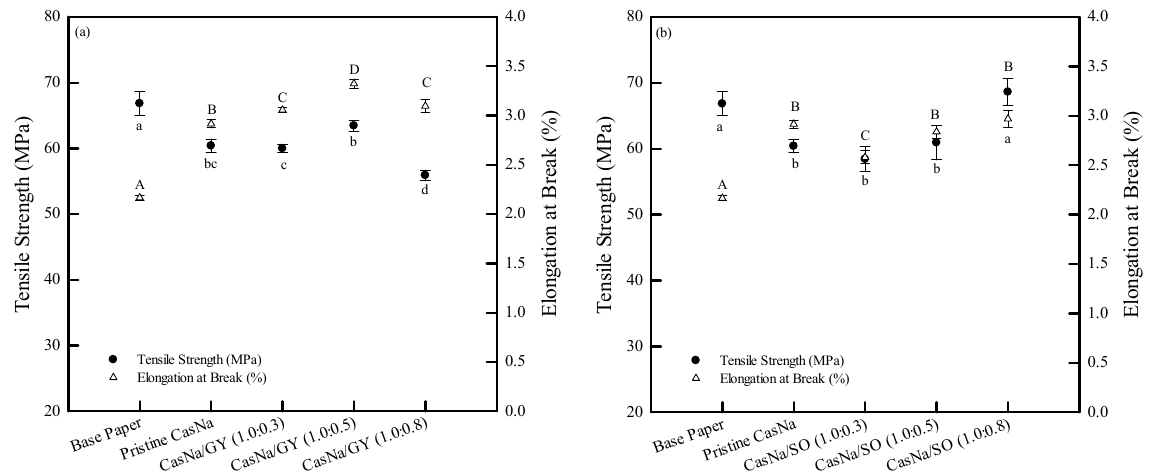
Figure 4. Tensile strength and elongation at break of ( a ) CasNa/GY–coated and ( b ) CasNa/SO–coated papers. Lowercase (a–d) and uppercase letters (A–D) indicate statistically significant differences of tensile strength and elongation at break, respectively ( p <